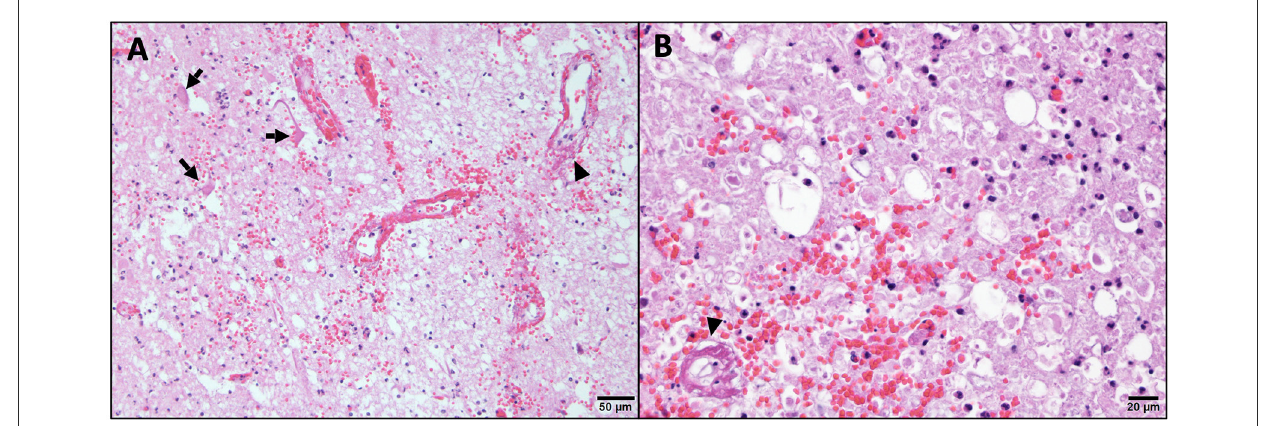
FIGURE4 Higher magnification of microscopic changes in the cervical spinal cord. Within the gray matter (A) , there is neuropil rarefaction and vacuolation with low numbers of residual neurons being angular and hypereosinophilic with no nucleus (arrow, necrosis). Within the white matter (B) , there is swelling and hypereosinophilia of axons and marked distension of myelin sheaths, some of which lack axons (axonal loss). In both the gray and white matter, there is multifocal hemorrhage, scattered infiltration by low numbers of neutrophils, and multiple vessel walls are partial to fully obscured by bright eosinophilic fibrillary material (arrow head, fibrinoid vascular necrosis). H&E